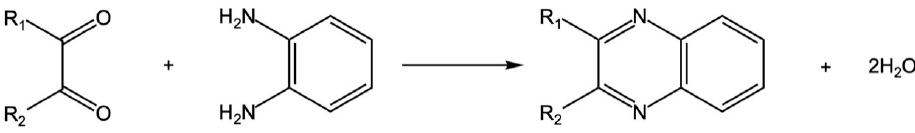
Figure 1. The reaction equation of OPD and α -DCs.